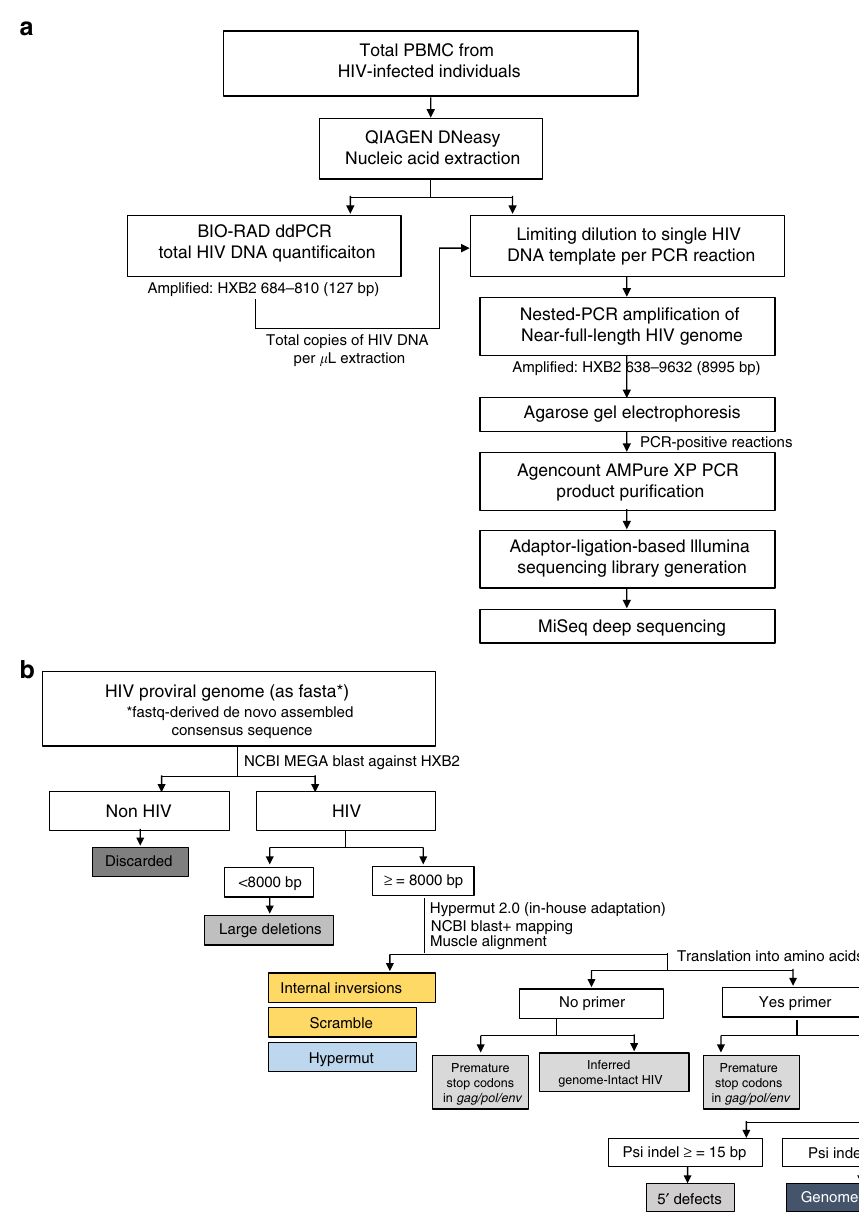
Fig. 2 Experimental and computational determination of viral genome intactness. a Sample processing pipeline for the generation of near-full-length HIV-1 sequences via single-genome-ampli fi cation. b Schematic representation of individual viral sequence analysis steps incorporated in the R-language HIVSeqinR script used for the determination of viral genome intactness in this study. A stable release (ver2.6) used in this study is available in GitHub